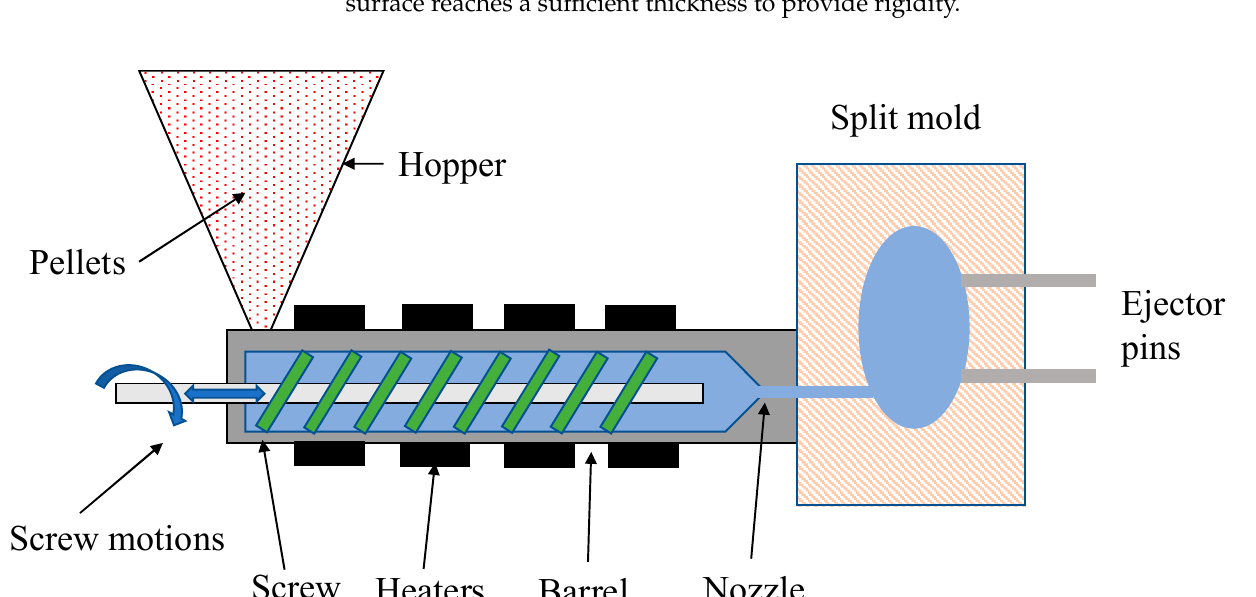
Figure 5. Schematic diagram of the injection molding method.